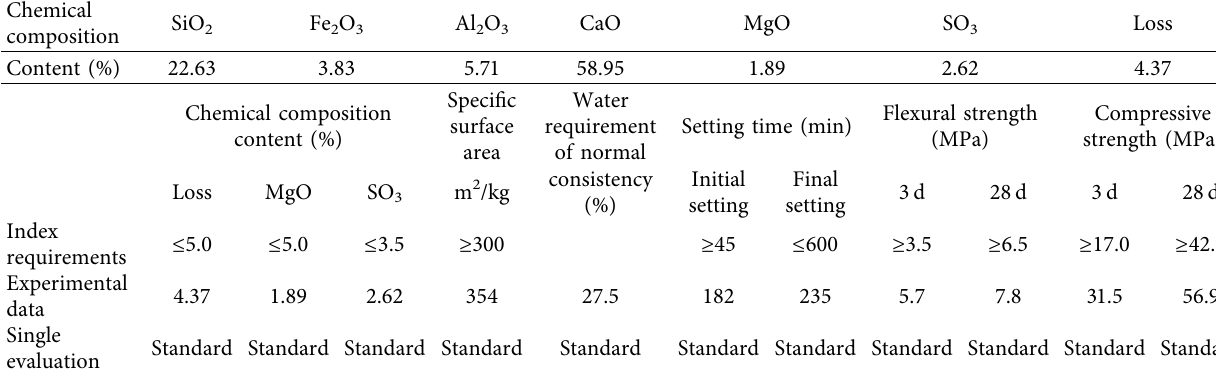
Table 1: Cement properties content and other natural requirements.